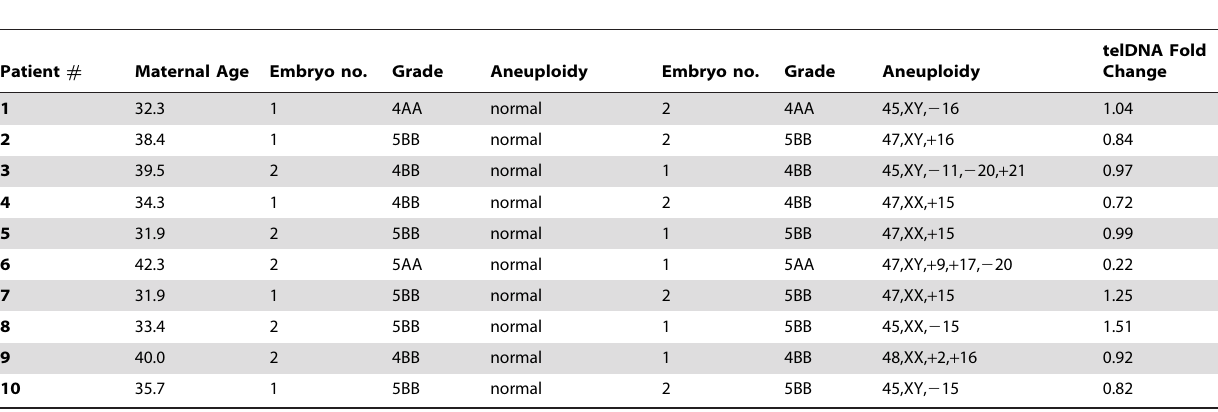
Table 3. Trophectoderm samples evaluated by microarray based aneuploidy screening and relative telomere DNA quantitation (aneuploid versus euploid).